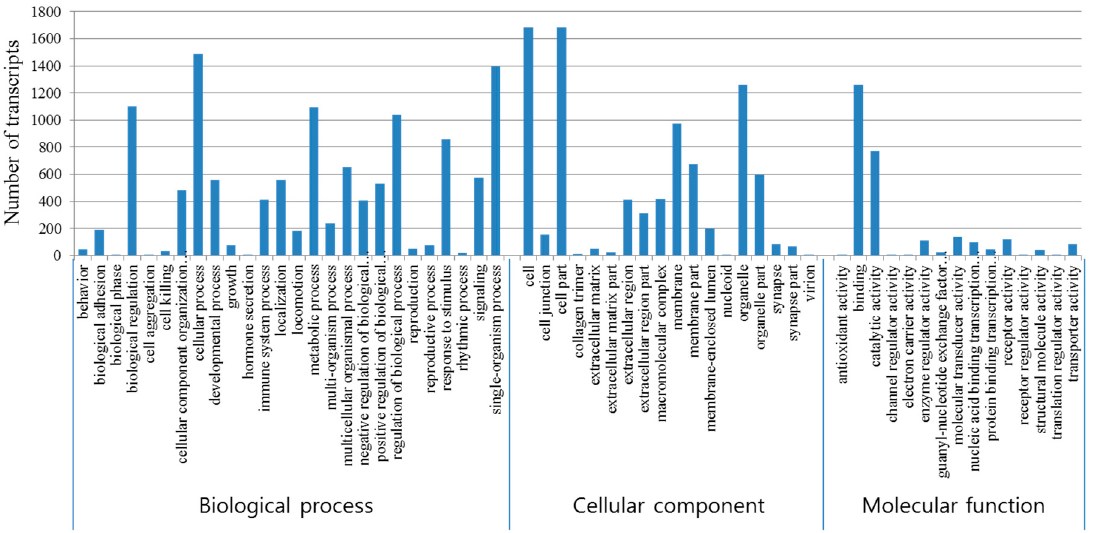
Figure 2. GO annotation of Differentially Expressed Genes (DEGs).